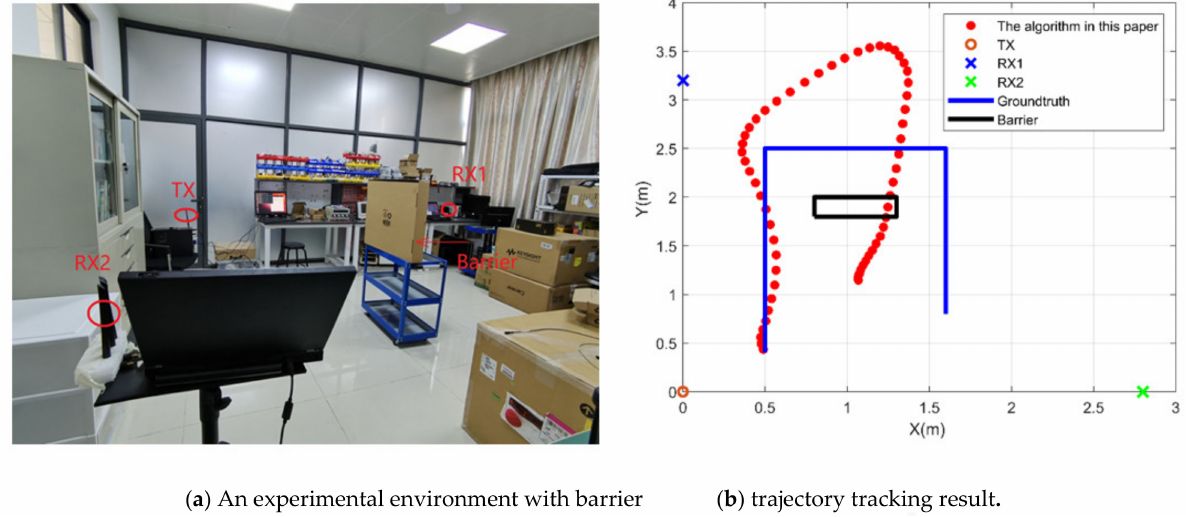
Figure 15. The experimental environment with barrier and trajectory tracking result in this